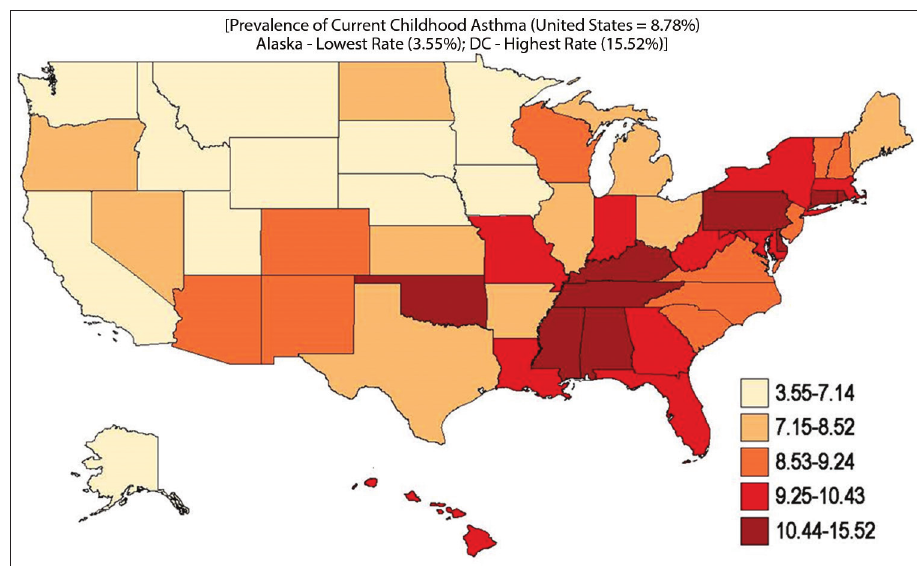
Figure 12. State Variation in Prevalence of Current Asthma among US Children and Adolescents Aged Under 18 Years, 2011-2012 National Survey of Children’s Health.